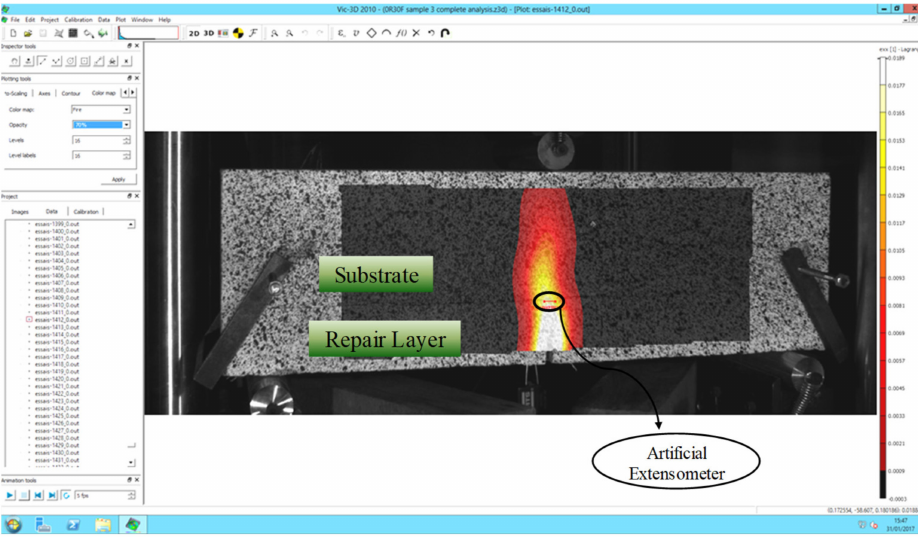
Figure 9. Placement of an artificial extensometer at the interface.